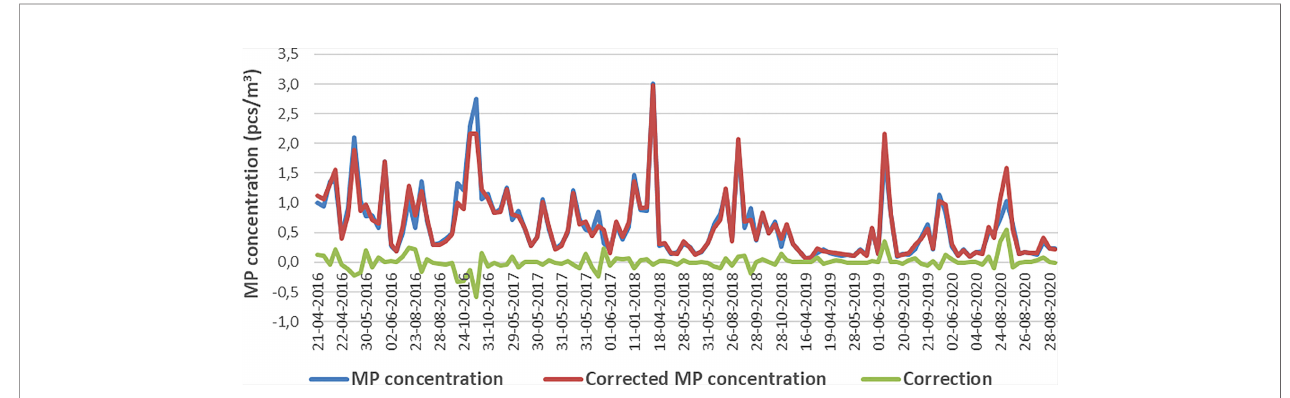
FIGURE 4 | MP concentrations from TalTech dataset during 2016-2020: blue – original estimation by using ship distance; red: corrected estimation by considering the surface currents and Stokes drift; green: the